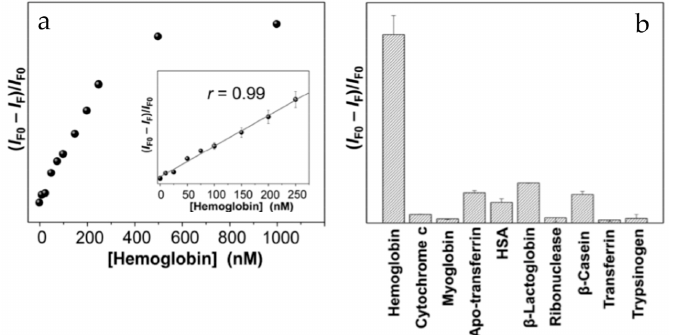
Figure 13. ( a ) Fluorescence quenching in the presence of haemoglobin; ( b ) selectivity of the C-dots for haemoglobin compared to a range of other biological compounds. Reproduced from reference [75] with permission from The Royal Society of Chemistry.